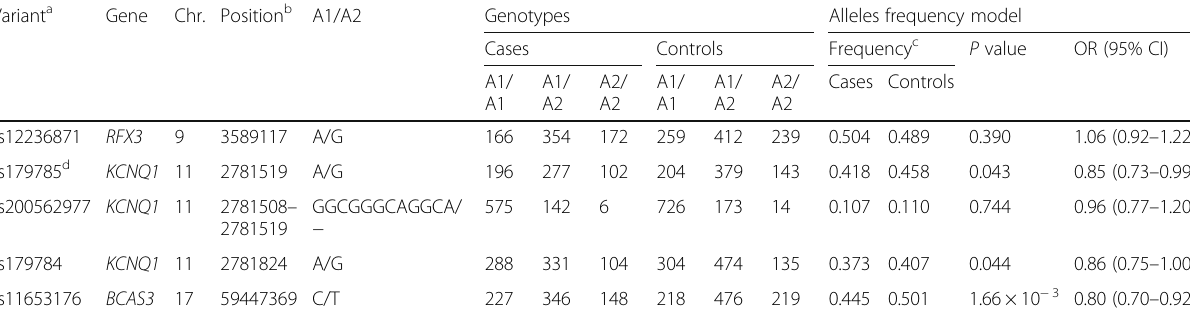
Table 1 Association analysis of three loci with 723 clinically-defined gout cases and 913 controls Variant a